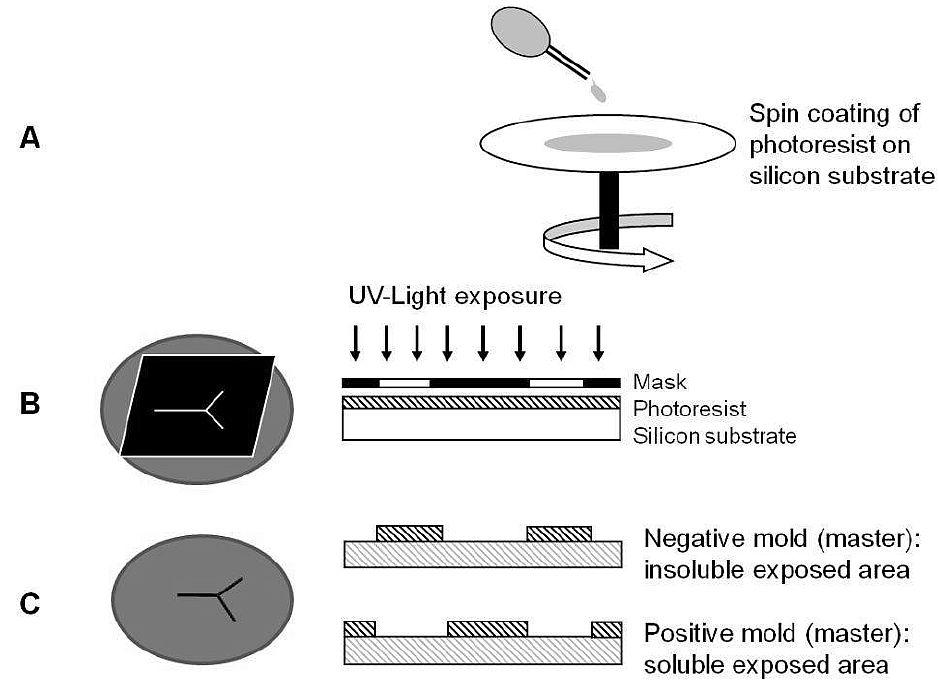
Figure 3. Photolithography to fabricate microfluidic devices. (A ) A photoresist is spin-coated on a silicon substrate; ( B ) The substrate with the spin-coated layer of photoresist is exposed to UV light through a high-resolution mask; ( C ) After baking and chemical development, the non-cross-linked material is removed, resulting in either a negative or a positive